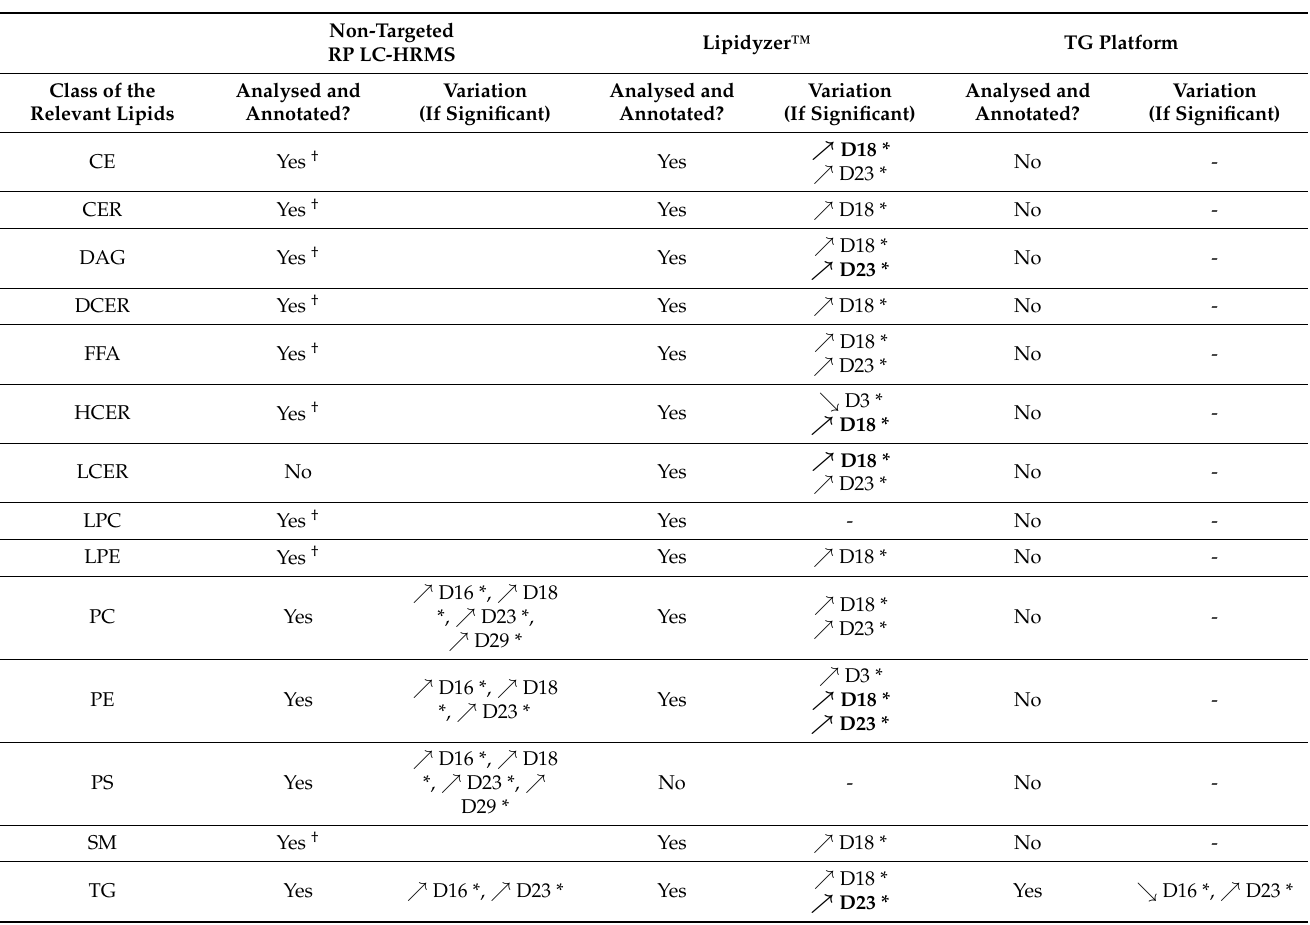
Table 5. Comparison of the results from various MS platform. The analysed lipid classes are mentioned with the level of significance, determined from a univariate Wilcoxon test.